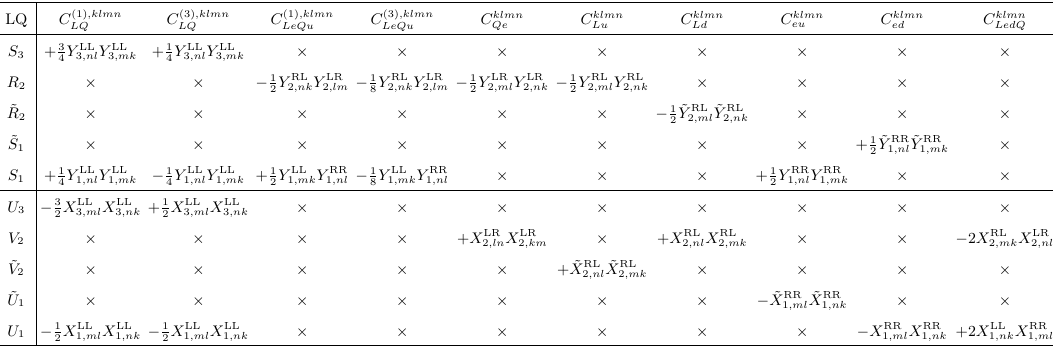
Table 3. Results of the matching of pairs of Yukawa couplings stemming from each leptoquark type listed in table 1 to the Wilson coefficients of the four-fermion operators of SMEFT from table 2. Notice that, owing to the Fierz rearrangement, we also obtain contributions containing tensorial operators, i.e. C (3) LeQu